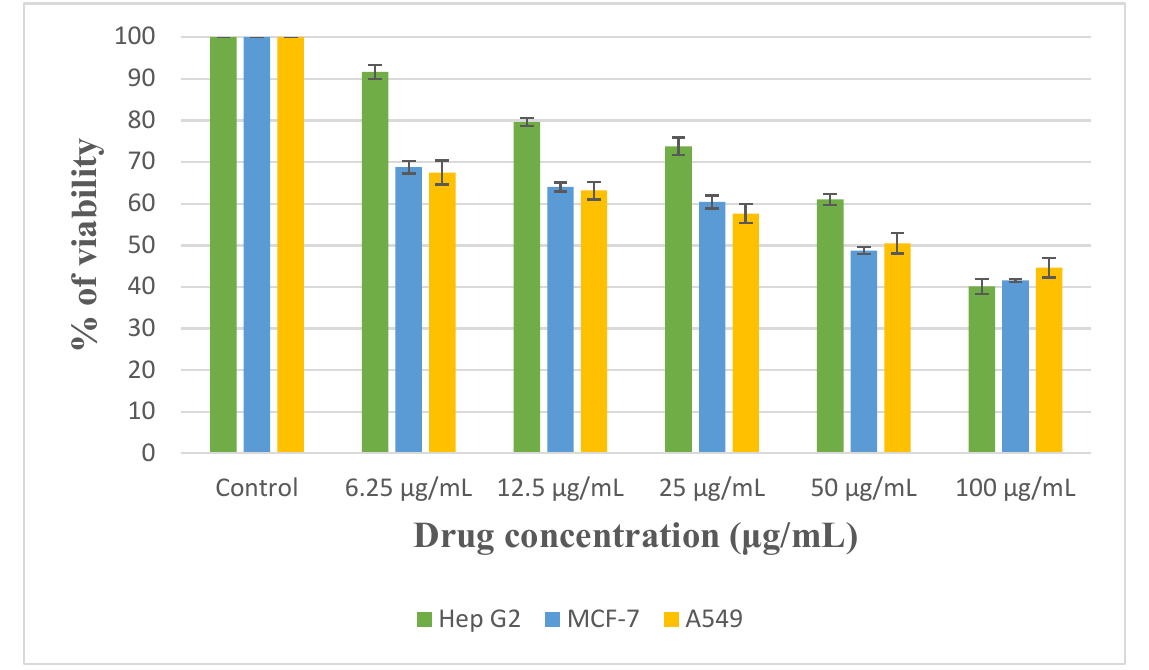
Figure 4. Graphical plot of in vitro cytotoxicity of the BiONP ‐β‐ CD ‐ Biotin system against Hep G2, MCF ‐ 7, and A549. Table 2. In vitro cytotoxicity of the BiONP ‐β‐ CD ‐ Biotin system against Hep G2, MCF ‐ 7, and A549. Hep G2 Cancer Cell